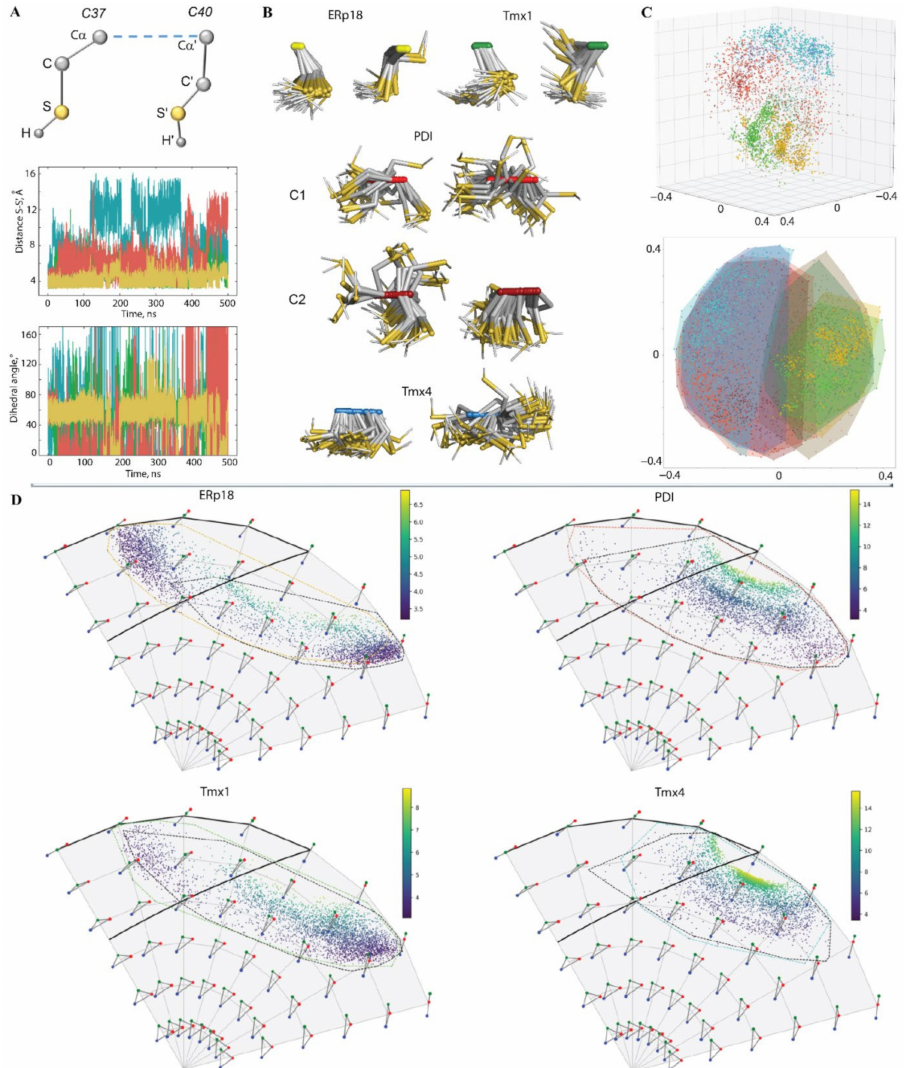
Figure 5. The CX 1 X 2 C motif geometries for ERp18, PDI, Tmx1 and Tmx4. ( A ) Geometry of the CX 1 X 2 C motif (left) is described by distance S · · · S’ (middle) and dihedral angle (right), determined as an absolute value of the pseudo torsion angle S − C α (C37) − C α ’(C40) − S’. Only one replica 2 is shown. ( B ) Superposition of the thiol groups (C α -C-S-H) from the CX 1 X 2 C motif of each protein is shown for either only one MD trajectory (ERP18, Tmx1 and Tmx4) or for both (PDI). Samples were taken for each 100-ns frame. ( C ) Multidimensional scaling (MDS) in 2D and 3D on the set of S-C-C-S tetrahedrons. Embedded points have been coloured according to the partner and replica they belong to. ( D ) Evolution of the shape of the triangles S-H · · · S on Kendall’s disk of 3D triangles; each data point is coloured according to the S · · · S distance. Representative triangles are regularly sampled on the disk. The thick black line delimits the area of conformations favouring H-bond interaction. The dashed areas are contouring subpopulations according to the S-atom being the